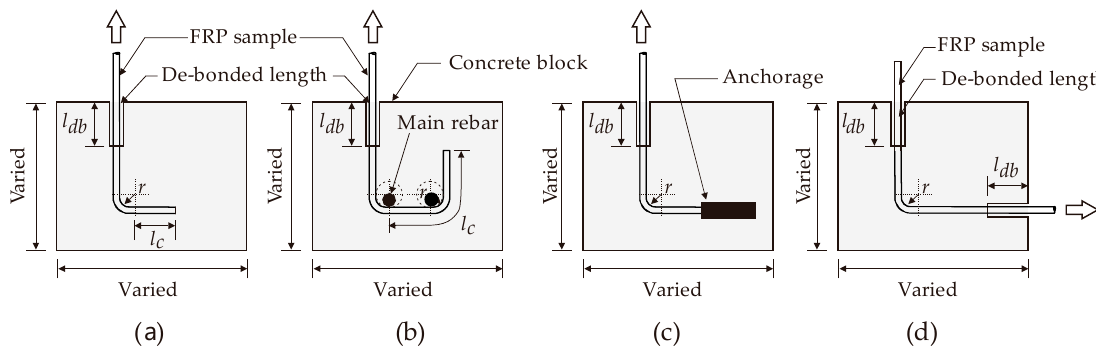
Figure 3. Different pullout setups for examining the bend capacity of FRP reinforcements; ( a ) J-hook specimen, ( b ) U-shaped specimen, ( c ) J-hook specimen with anchorage, and ( d ) J-hook specimen with unbonded unloaded end (illustration adopted from [38]).